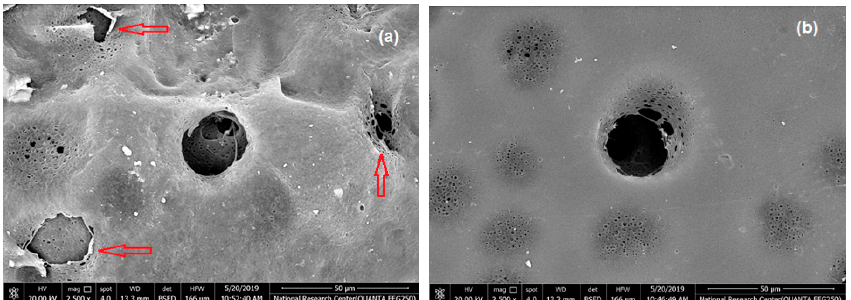
Figure 5. SEM of the PSF / 2%RSNF membrane surface: ( a ) after water flux test and ( b ) before water flux test.